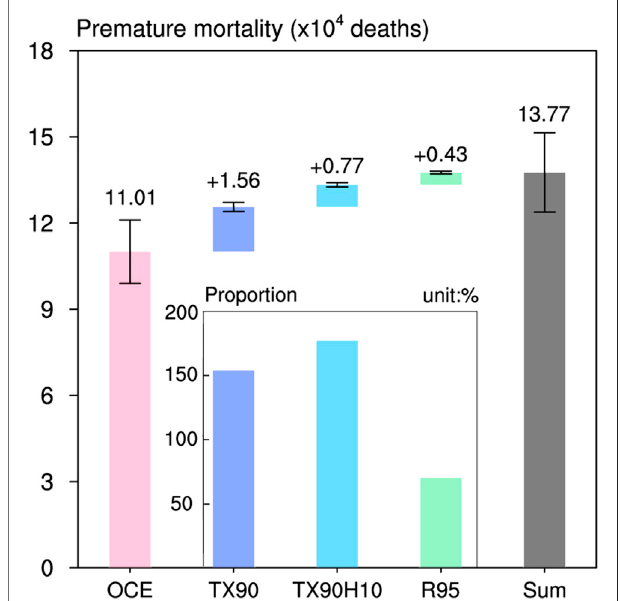
FIGURE 4 | Numbers of premature deaths in East of China corresponding to TX90, TX90H10, R95, OCE, and their accumulated total in the summers of2015 – 2021. Vertical black bars represent the ±10% intervals. The proportions of area-averaged premature death during TX90, TX90H10, and R95 with respect to those during OCE were also displayed in the inner